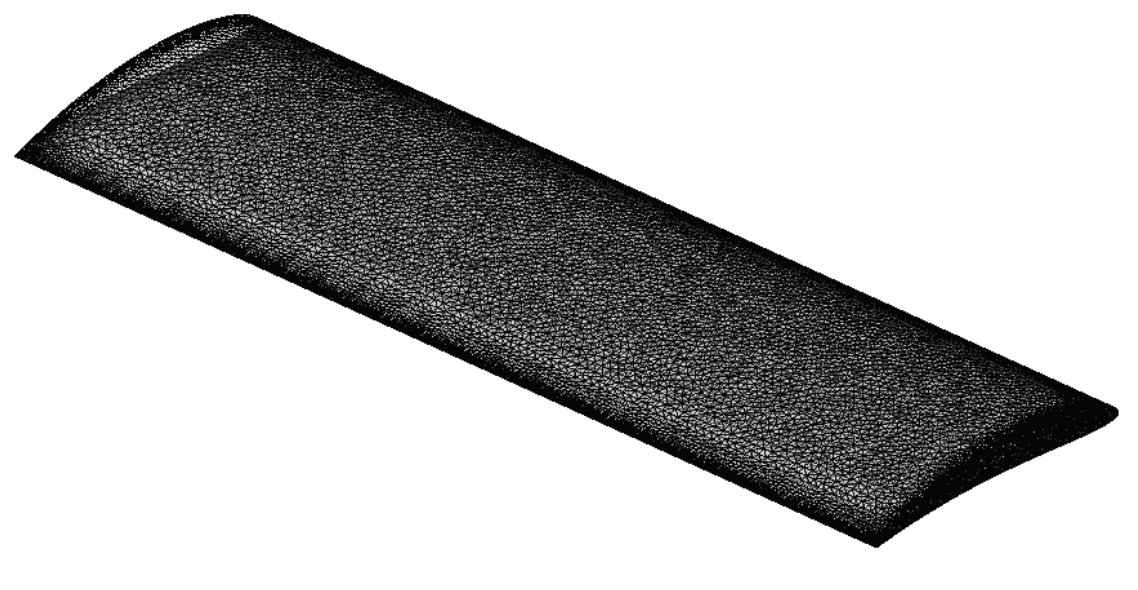
Figure 25. Generated aerodynamic mesh over the wing.